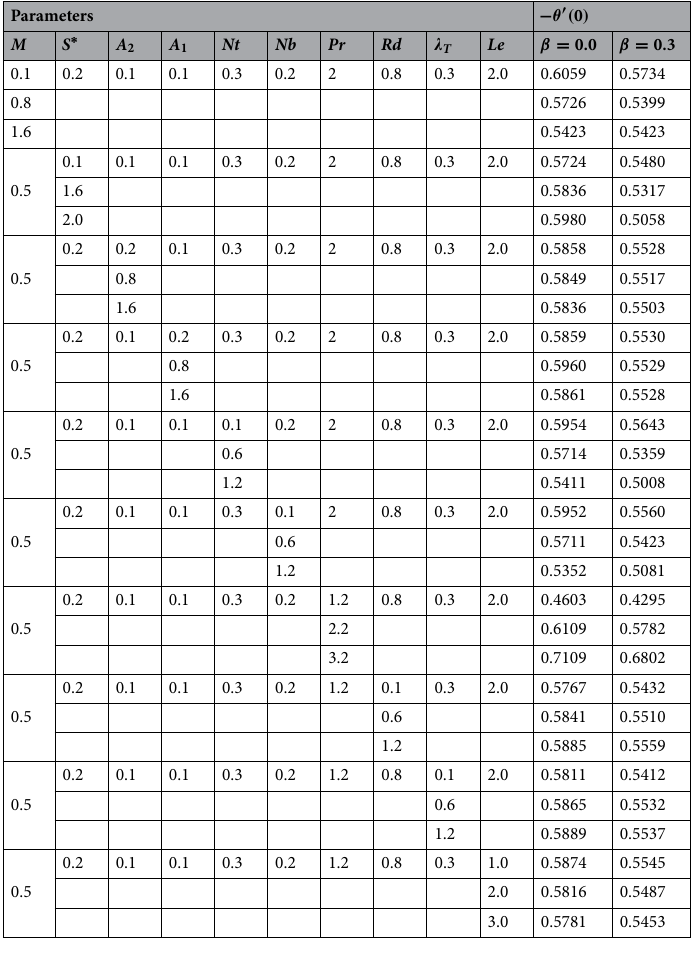
Table 3. Outcomes of − f ′′ ( 0 ) versus M , S ∗ , A 1 , A 2 , Nt , Nb , Pr , Rd , (cid:31) T and Le